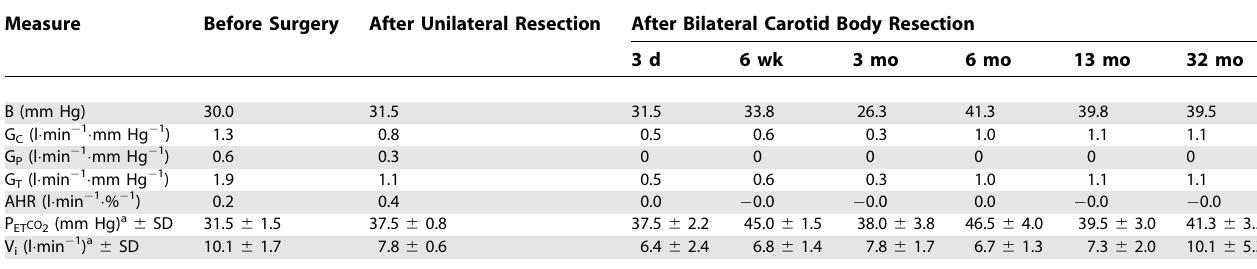
Table 1. Resting Variables and Parameters Obtained from the CO 2 and Hypoxic Challenges of Patient 3 over Time Measure Before Surgery After Unilateral Resection After Bilateral Carotid Body Resection